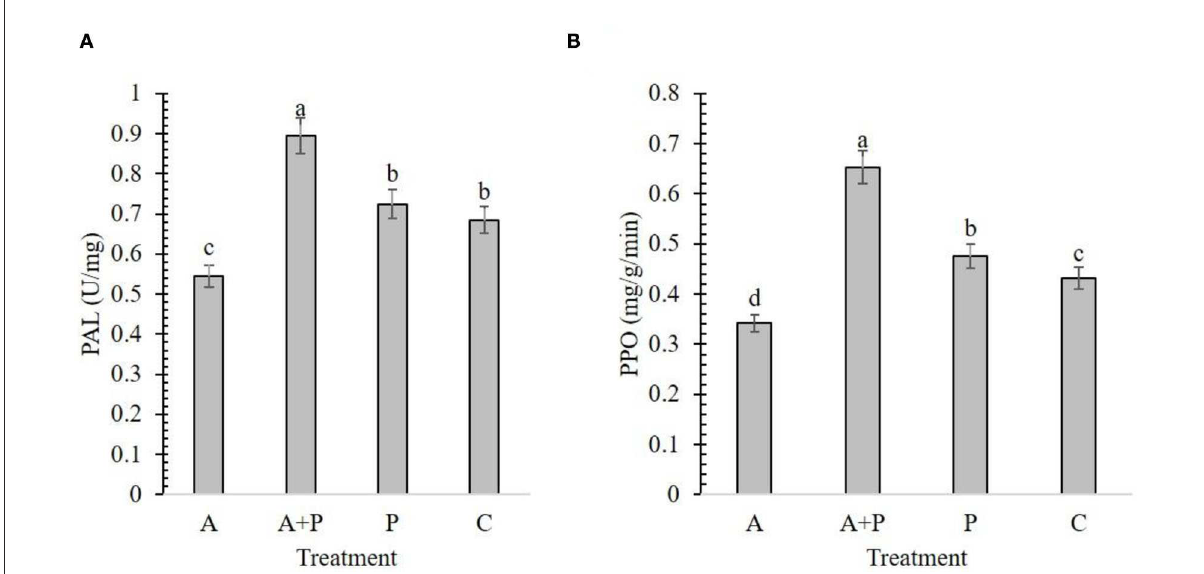
FIGURE3 Effect of different treatments [A, alga ( S. angustifolium ) extract; A + P, pathogen ( M. phaseolina )-inoculated pre-treated with the alga extract; P, pathogen-inoculated; C, control] and on the activity of strawberry enzymes including PAL (A) and PPO (B) . Letters on bars show the significant difference between the treatments according to the results of Duncan’s multiple range